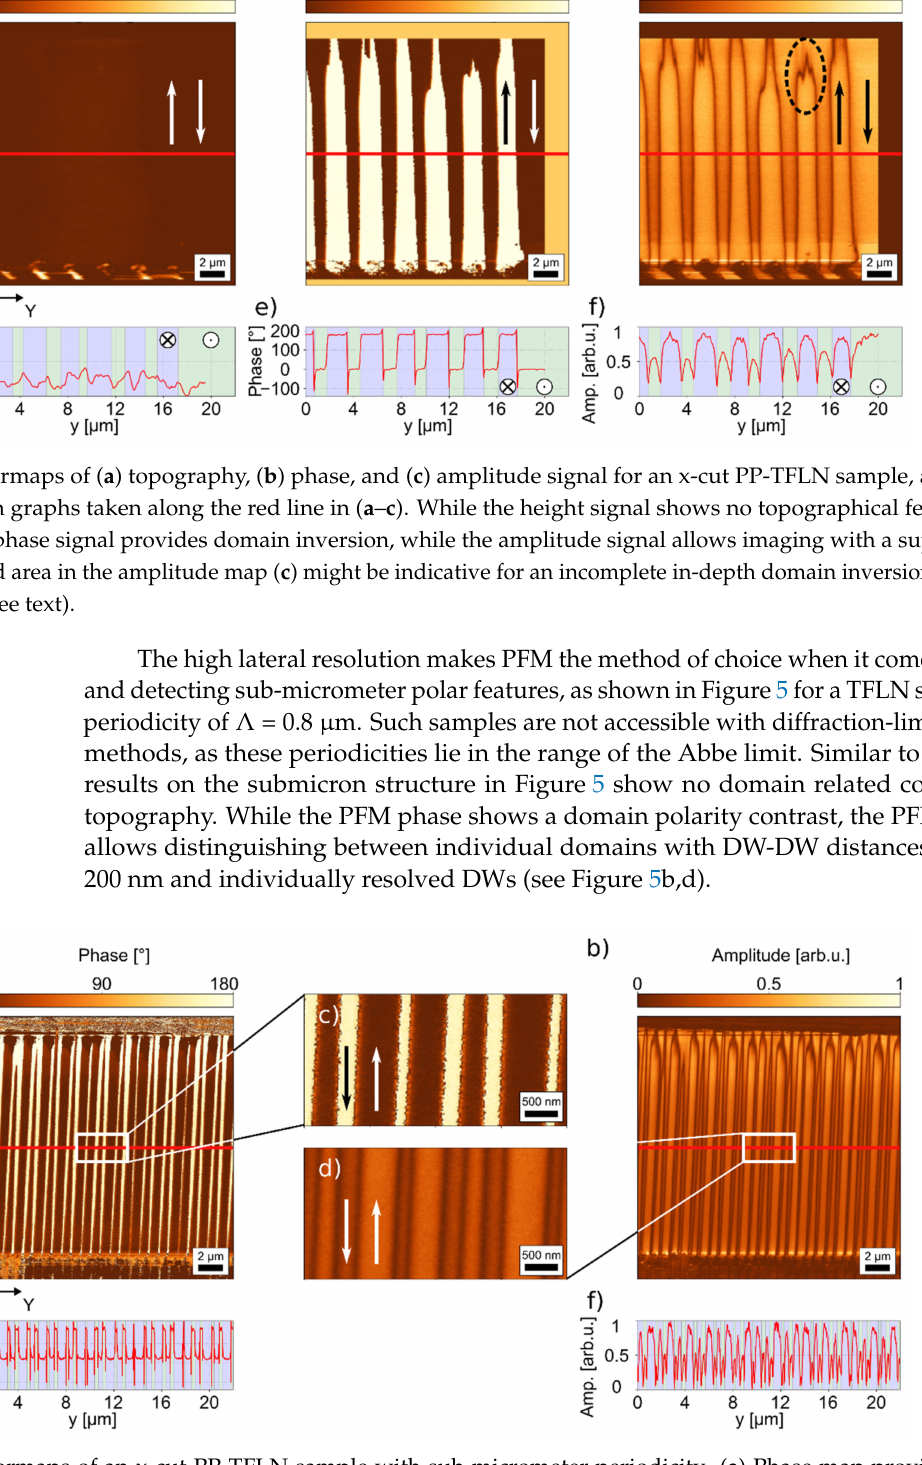
Figure 5. PFM colormaps of an x-cut PP-TFLN sample with sub-micrometer periodicity. ( a ) Phase map providing the domain polarity contrast. ( b ) Amplitude map with the domain wall contrast. ( c ) and ( d ) Zoomed-in map segments of the phase ( c ) and amplitude ( d ) maps that demonstrate high-resolution imaging of sub- µ m domains. ( e ) and ( f ) Line scan graphs of ( e ) phase and ( f ) amplitude maps along the red lines indicated in the respective